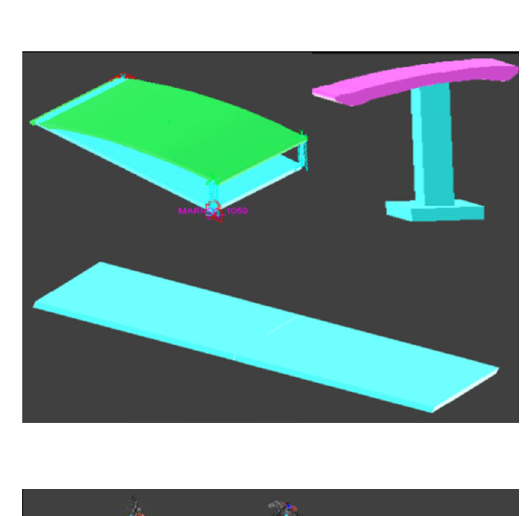
Fig. 8 Contact between the human body model and the